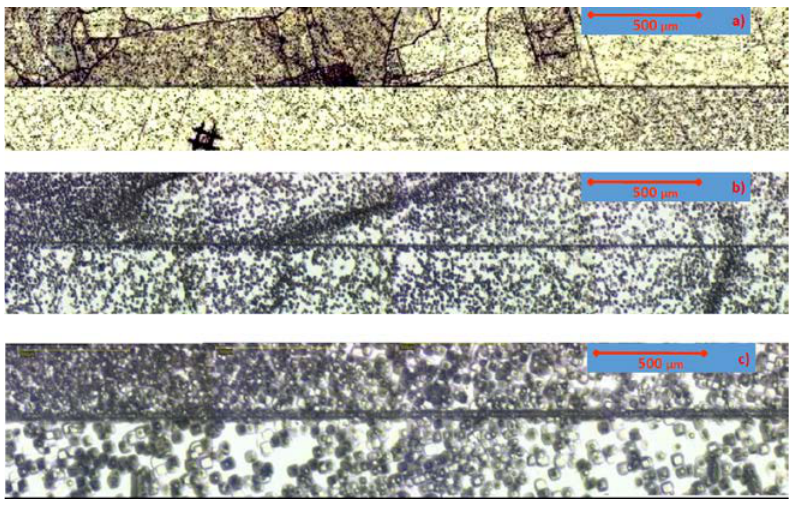
Figure 12. Collections of the etch pits distributions, close to the bicrystalline boundary (36.8°), of SrTiO 3 bicrystals from different suppliers: ( a ) Shinkosha; ( b ) CrysTec; ( c ) MaTecK.